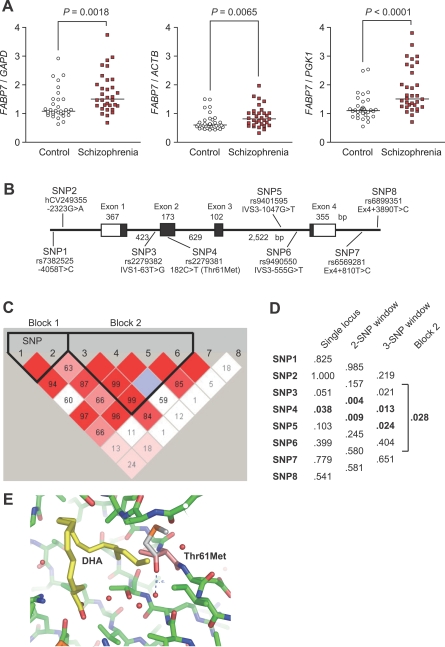
Expression and Genetic Analyses of Human FABP7
(A) Relative mRNA levels of FABP7 in the BA 46 region of control and schizophrenic postmortem brains.(B) Genomic structure and location of polymorphic sites in FABP7. Exons are denoted by boxes, with untranslated regions in white and translated regions in black. The sizes of exons and introns are also shown. “rs” is an NCBI I.D. nomenclature (http://www.ncbi.nlm.nih.gov/) and ”hCV” is derived from the Celera Discovery System (https://www.appliedbiosystems.com/).(C) The haplotype block pattern of the FABP7 interval is shown. The number in each cell represents the linkage disequilibrium parameter D' (×100), red cells mean D' = 1. Each cell color is graduated relative to the strength of linkage disequilibrium between markers, which is defined by both the D' value and confidence bounds on D'. Note that the FABP7 region consists of two haplotype blocks.(D) Allelic p-values for single-locus and global p-values from multilocus (two, three, and block 1) association analysis. Minor allele frequency data in control samples for individual SNPs were as follows: SNP1 (C = 0.09), SNP2 (A = 0.34), SNP3 (G = 0.36), SNP4 (T = 0.03), SNP5 (G = 0.38), SNP6 (T = 0.24), SNP7 (C = 0.10), and SNP8 (C = 0.36).(E) The site of the missense polymorphism (SNP4), Thr61Met in the FABP7 structure. The methionine residue (white) overlaps with Thr61 (magenta) of the crystal structure with DHA (yellow) (PDB ID: 1FDQ) [52]. The side-chain rotamer of methionine is arbitrary. A hydrogen bond between Thr61 and a water molecule is shown as a blue dashed line. The graphic was created using PyMOL (DeLano Scientific).